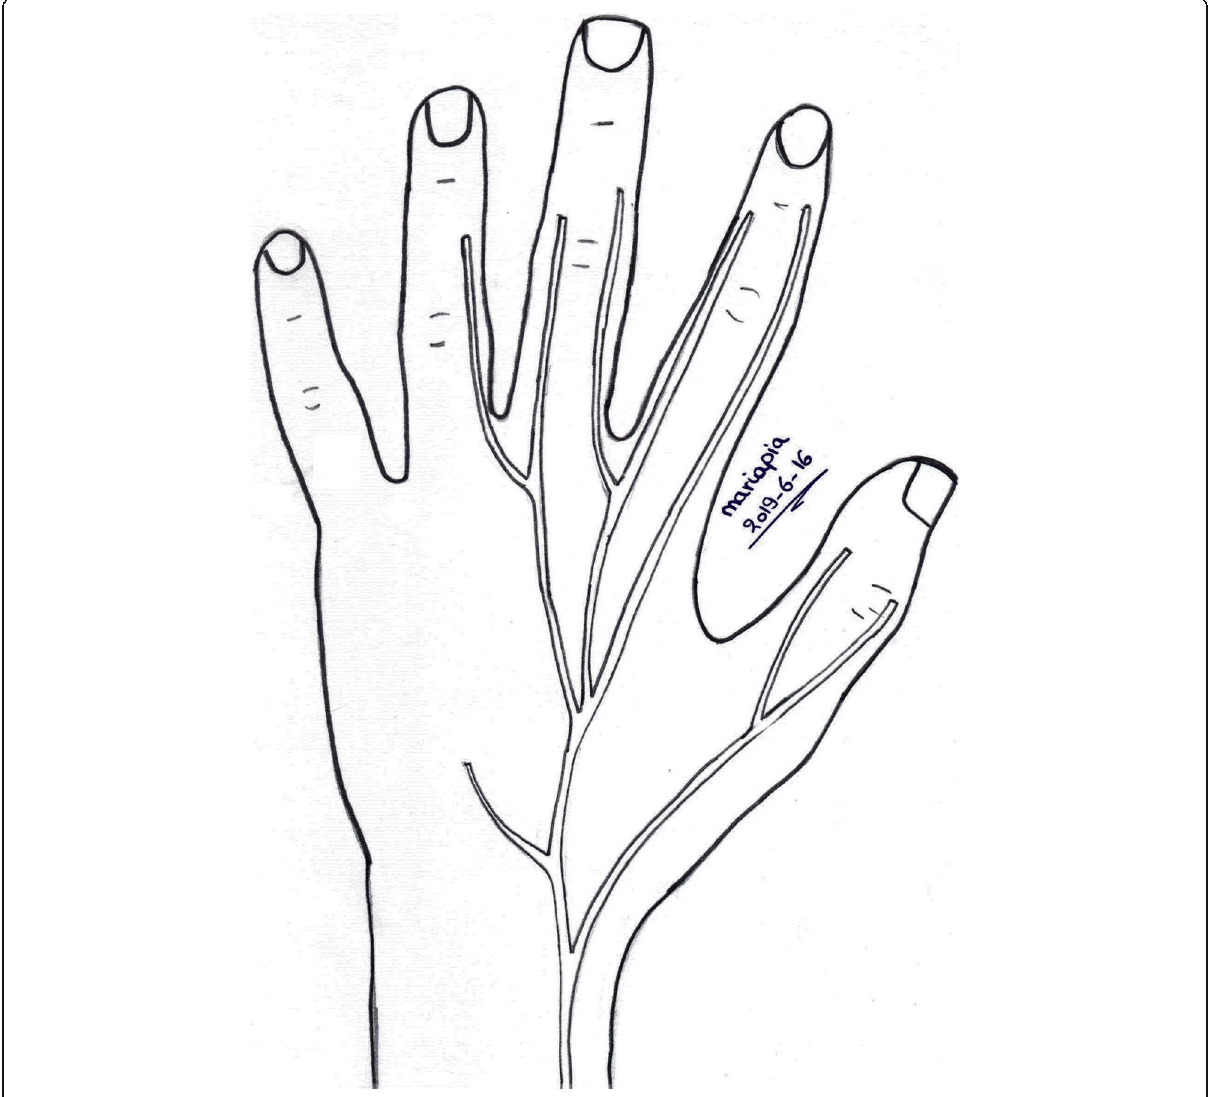
Fig. 1 An illustration representing the terminal anatomical course of superficial radial nerve